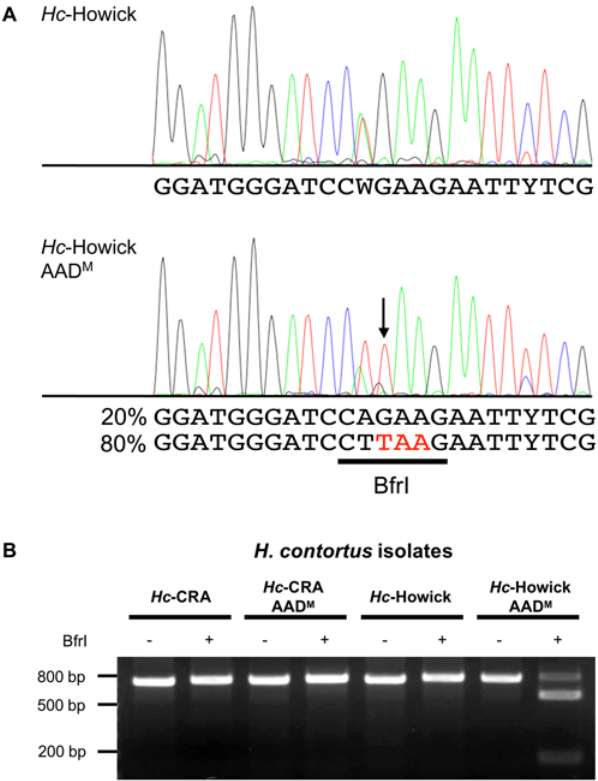
Figure 6. Detection of a nonsense mutation in Hc -Howick AAD M worms. (A) Direct sequencing of RT-PCR products revealed a transversion in exon 6 from G to T (arrow) in the Hco-mptl-1 gene that leads to a premature stop at codon 93 (TAA; shown in red) in about 80% of Hc -Howick AAD M mutants as estimated from the electrophe- rogram. (B) The point mutation creates a restriction site for the endonuclease BfrI (CTTAAG; underlined). Only the product amplified from cDNA of the Hc -Howick AAD M mutant could be